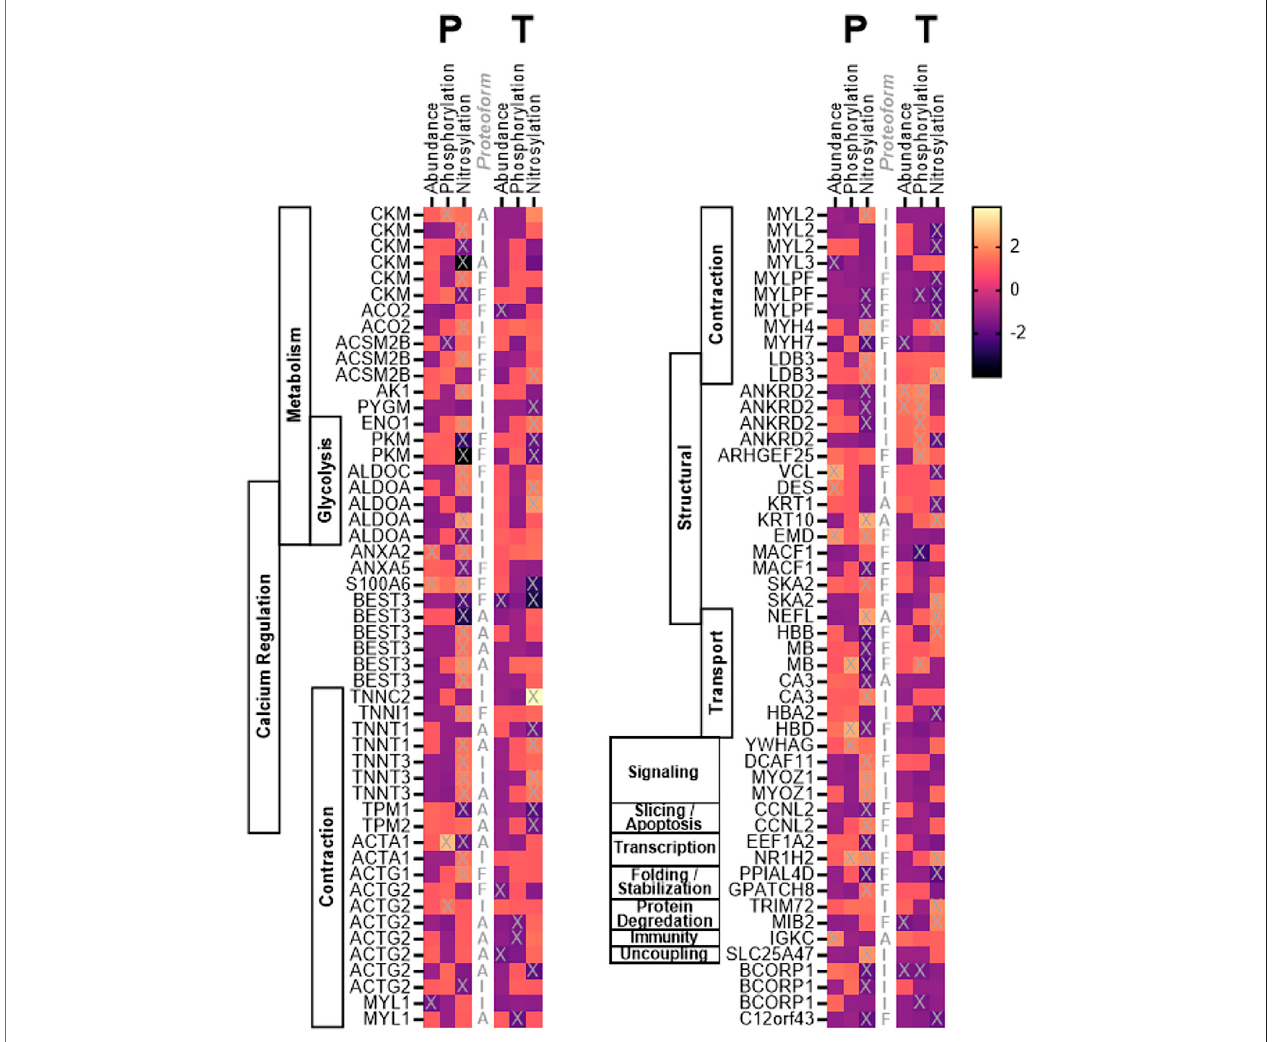
FIGURE 1 | Heat map. Heat map depicting the fold change in abundance, phosphorylation, and S-nitrosylation of skeletal muscle proteins in cancer patients following7 weeksoftreatmentwithtestosterone(T)orplacebo(P).Proteoformsmarkedwith “ X ” changedsigni fi cantly( p < 0.05)frompretoposttreatment.Proteoforms are labeled (central column) as either intact (I), fragments (F), or aggregate (A) based on identi fi cation and predicted molecular weight as described in the